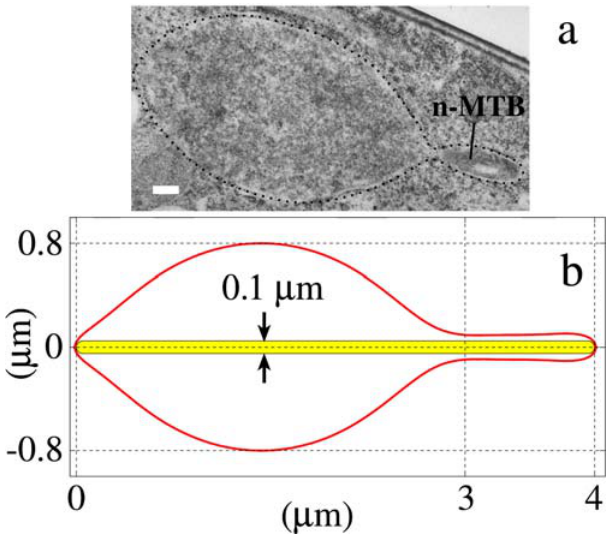
Figure 4. (a) Electron micrograph of thin section of an abnormally shaped nucleus (dotted outline)witha n-MTB due tooverexpression of the ned1gene [ 6 ] . The n-MTB extends across the nucleus but is only partially visible in this section. Based on this and the other sections (not shown), we estimate that the bulge dimensions are approximately 1.6 m m 6 3.0 m m and the n-MTB radius is approximately 0.05 m m. Bar: 0.2 m m. (b) Predicted stable axisymmetric surface S with the same scale as above, obtained by adjusting T/B and V net so that its bulge dimensions match the actual ones, with the constraints t i =0.016 m m, L =4 m m, and r =0.05 m m. Its size measures are A =11.43 m m 2 and V net =2.90 m m 3 , corresponding to T/B =65 m m 2 2 and P/B =134.28 m m 3 , respectively.